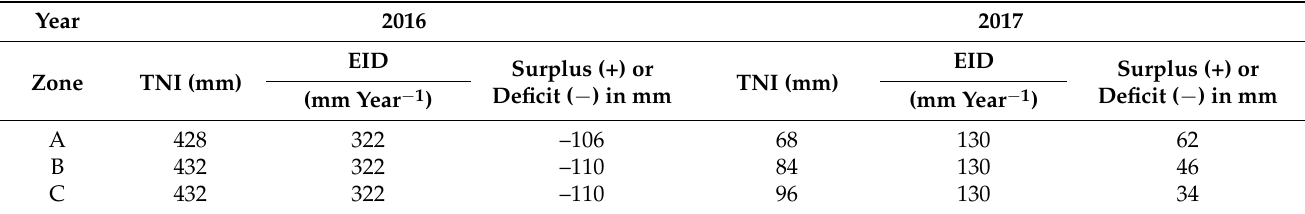
Table 5. The TNI and EID values for the years 2016 and 2017 according to the management